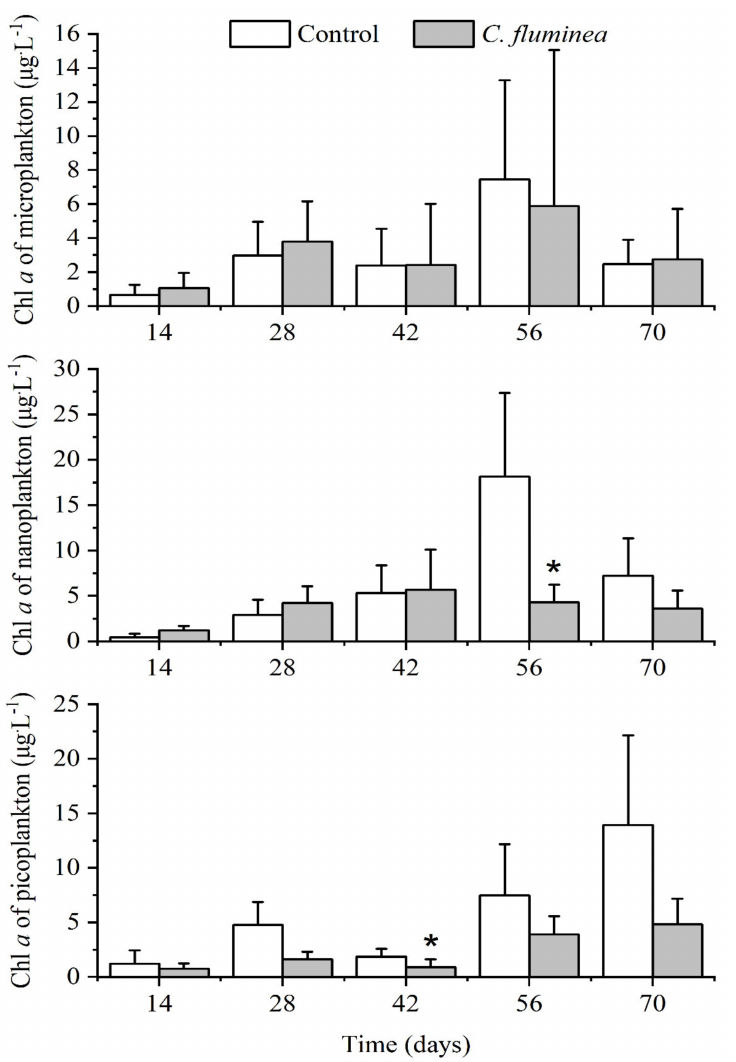
Figure 6. Chl a of microplankton (mean ± SD), nanoplankton (mean ± SD), and picoplankton (mean ± SD) in different treatments over time. Asterisk indicates significant differences between the treatments and controls ( p <